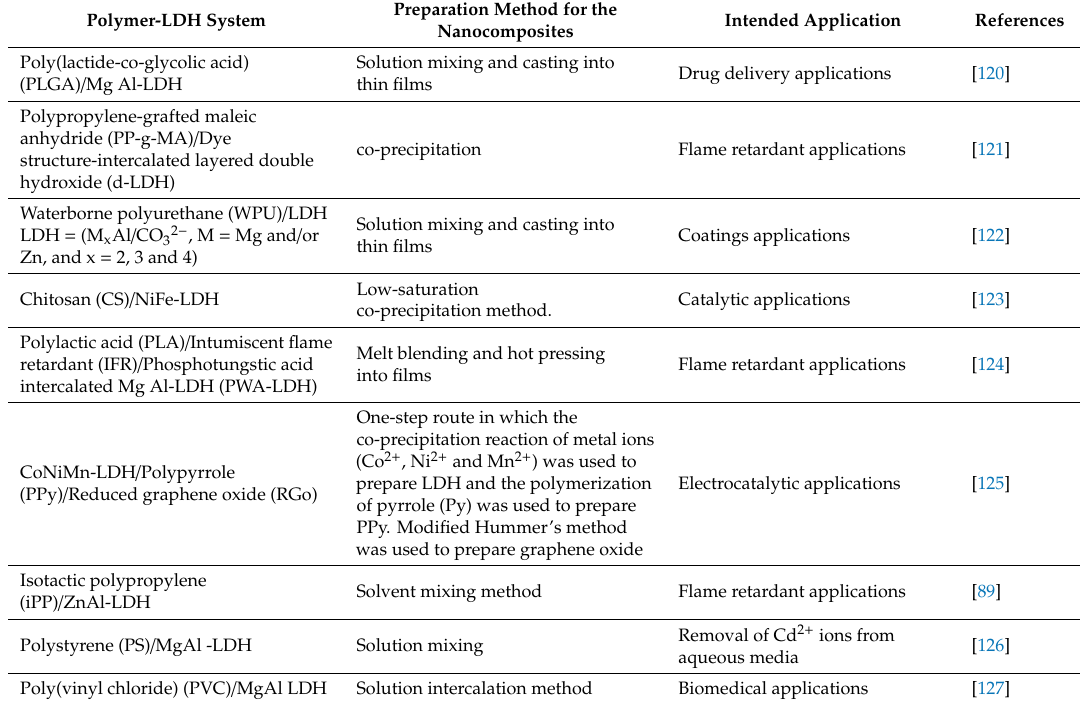
Table 6. Summary of selective studies on the application of LDH-polymer